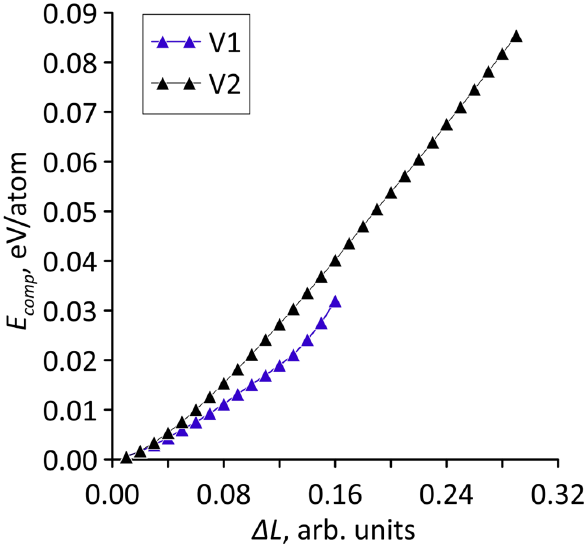
Figure 8. Dependence of the strain energy of bilayer graphene-SW С NT (12,6) hybrid fi lms on the magnitude of compression in relative units for supercells of topological models V1 and V2.